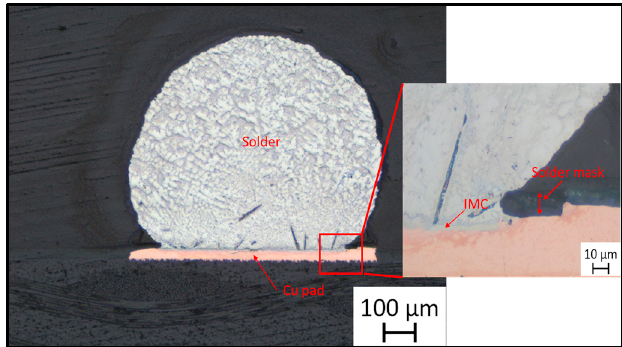
Figure 1. Test vehicle design.